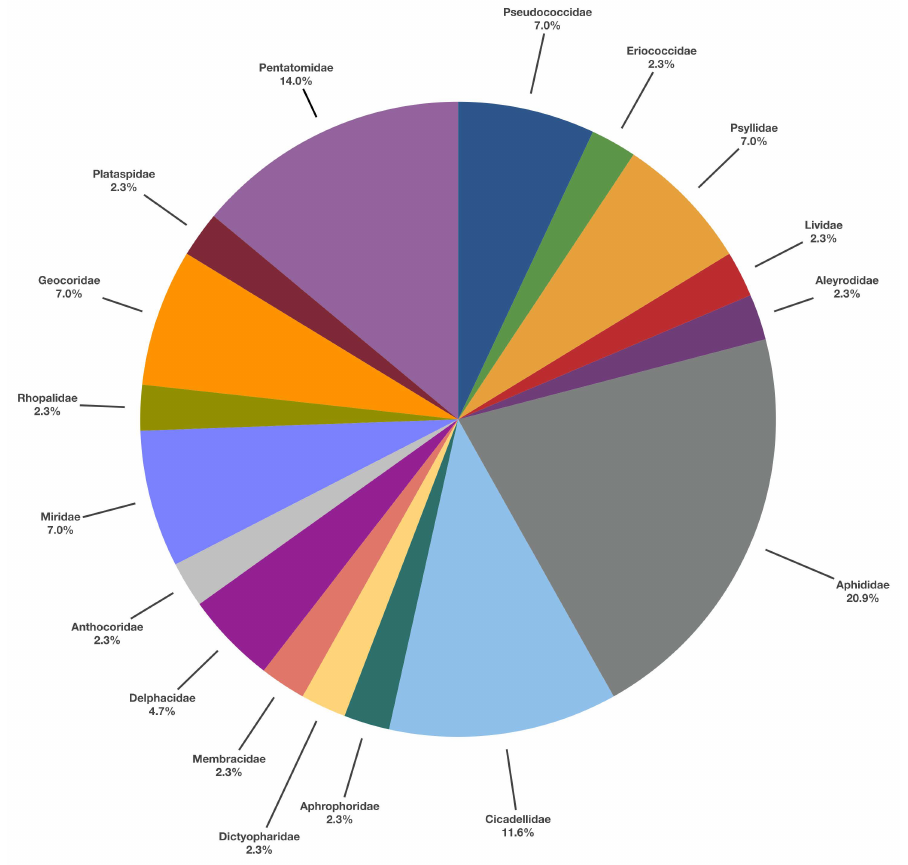
Figure 6. Relevance of Hemiptera families preyed by LAB according to available literature survey. Beneficial insects as Chrysoperla carnea (Stephens, 1836), Adalia bipunctata (L., 1758) and A. mellifera only represent the 2.4%, 1.2% and 1.2%, respectively, of LAB’s